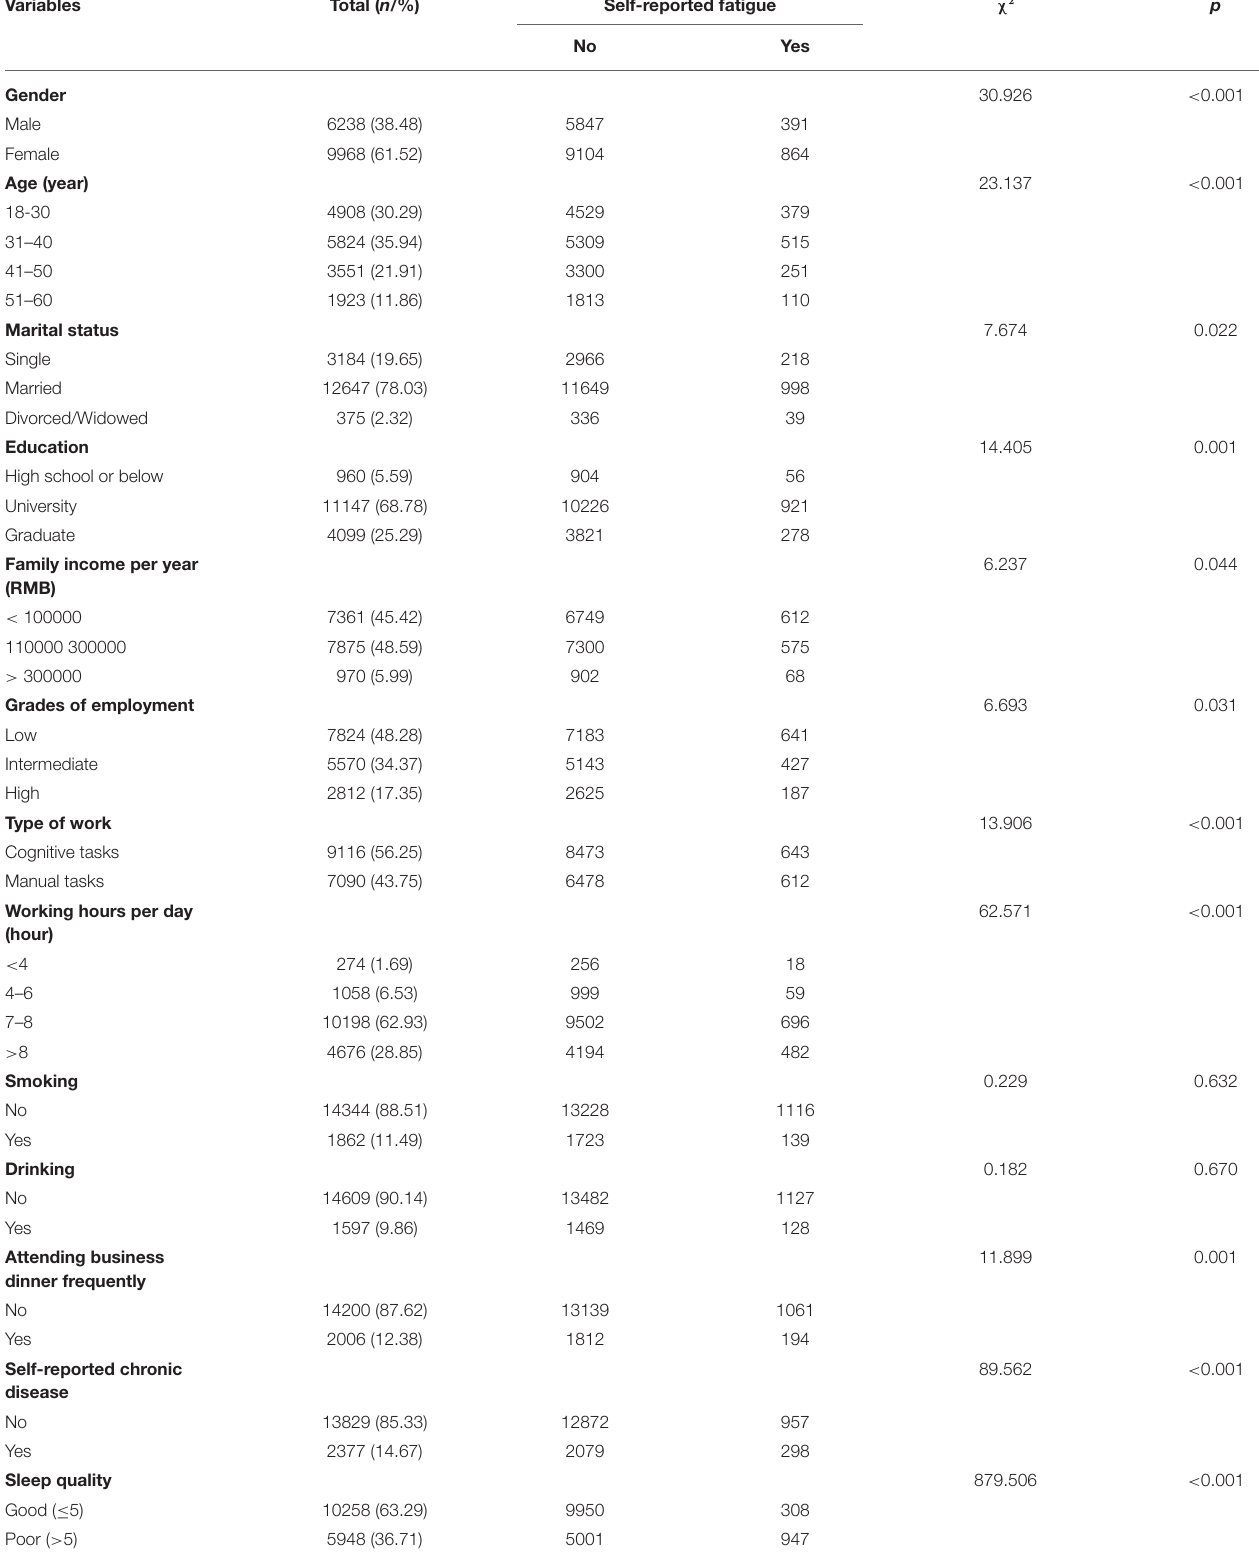
TABLE 1 | Socio-demographic characteristics, stressful life events between employees with/without chronic fatigue at baseline ( n = 16206).